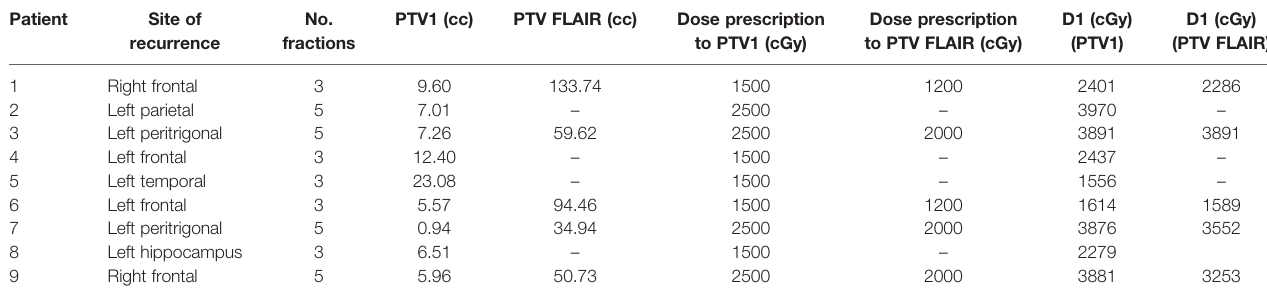
TABLE 3 | Treatment details of HRT.